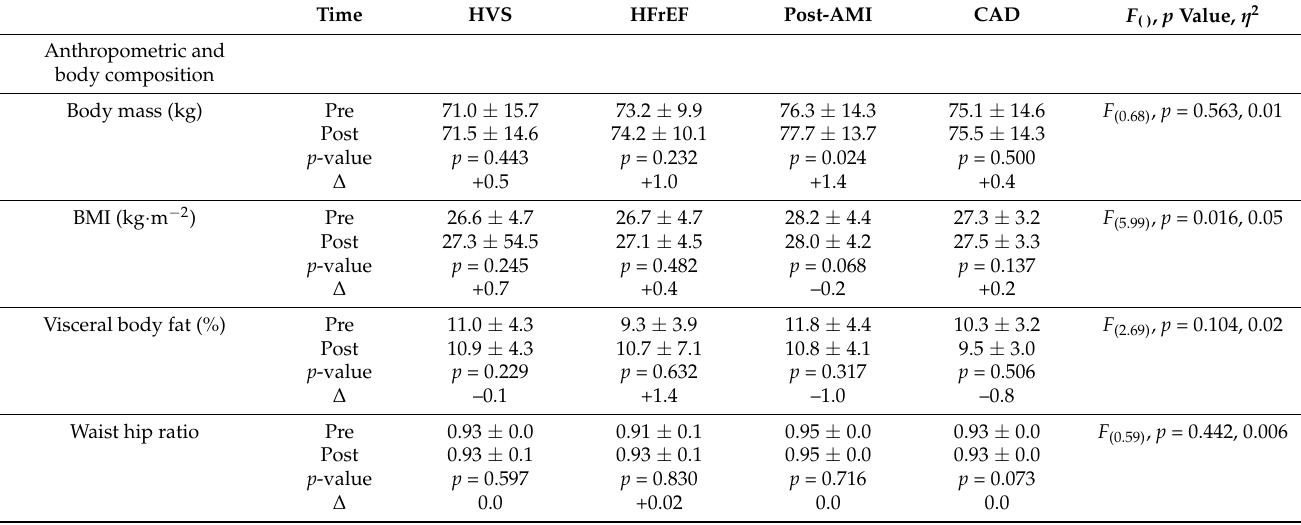
Table 2. Changes in secondary outcomes of anthropometric, body composition, cardiorespiratory per- formance, quality of life and emotional role in four different samples of patients with cardiovascular disease participants of a concurrent training exercise